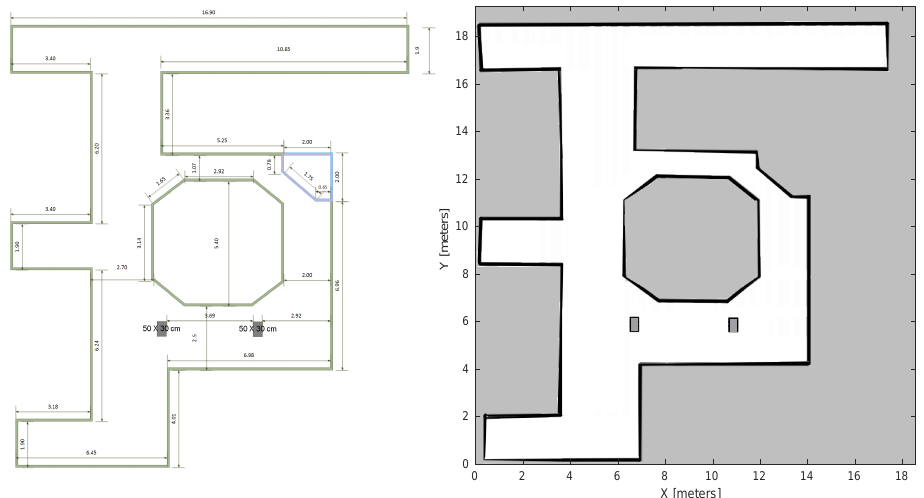
Figure 8. Real measurements and occupation map of the work